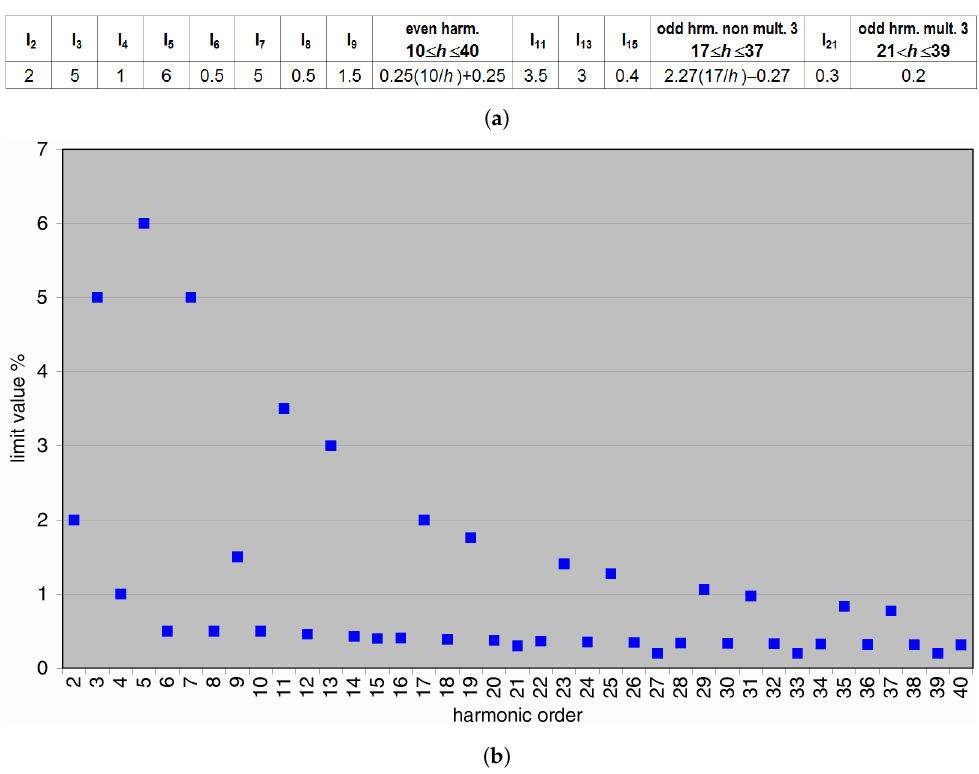
Figure 2. Harmonic distortion compatibility levels for public LV distribution grid (Table 1 of IEC 61000-2-2), with a prescribed voltage THD level of 11%: ( a ) numeric values, ( b ) graphical